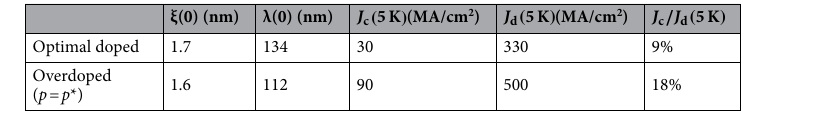
Table 1. Estimation of the ratio of critical current density of this work, J c , over depairing critical current density, J d . ξ( 0 ) and J c obtained within this work, (cid:31) ( 0 ) from 40 and J d calculated using Eq.